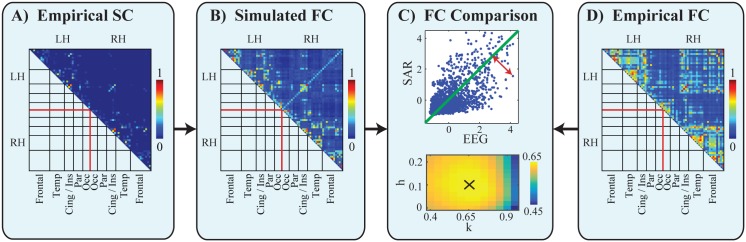
Comparison of empirical and simulated FC in the reference procedure.A: Structural connectivity among 66 cortical regions after normalization for ROI size and excluding self-connections (see chapter Reference Procedure, section Reconstructing the structural connectome). B: The correlation of the simulated network based on structural connectivity using the SAR model with optimal global scaling parameter k = 0.65 and homotopic connection strength h = 0.1. C: Upper: The respective simulated (k = 0.65, h = 0.1) and empirical connection strengths are z-transformed and plotted for each connection. Correlation is used as a global performance measure. The local model error per connection is evaluated as the distance (red arrow) to the total-least-squares fit (green line). Lower: Color indicates the correlation strength at a range of different global connection strength scaling parameters k, and fraction of added homotopic connections (h). The black cross indicates the parameters with the maximum correlation. D: The empirical functional connectivity as the coherence between source reconstructed time series at the cortical regions. All connectivity matrices (A, B, D) were normalized to have strengths between 0 (no connection) and 1 (strong connection).